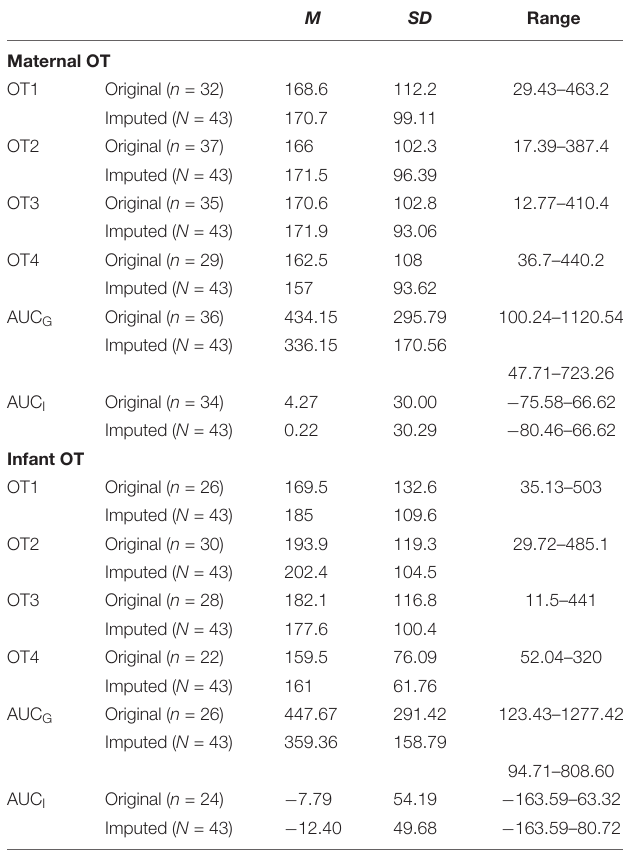
TABLE 4 | Descriptive statistics for original and imputed OT measures (in pg/ml) of the present study.